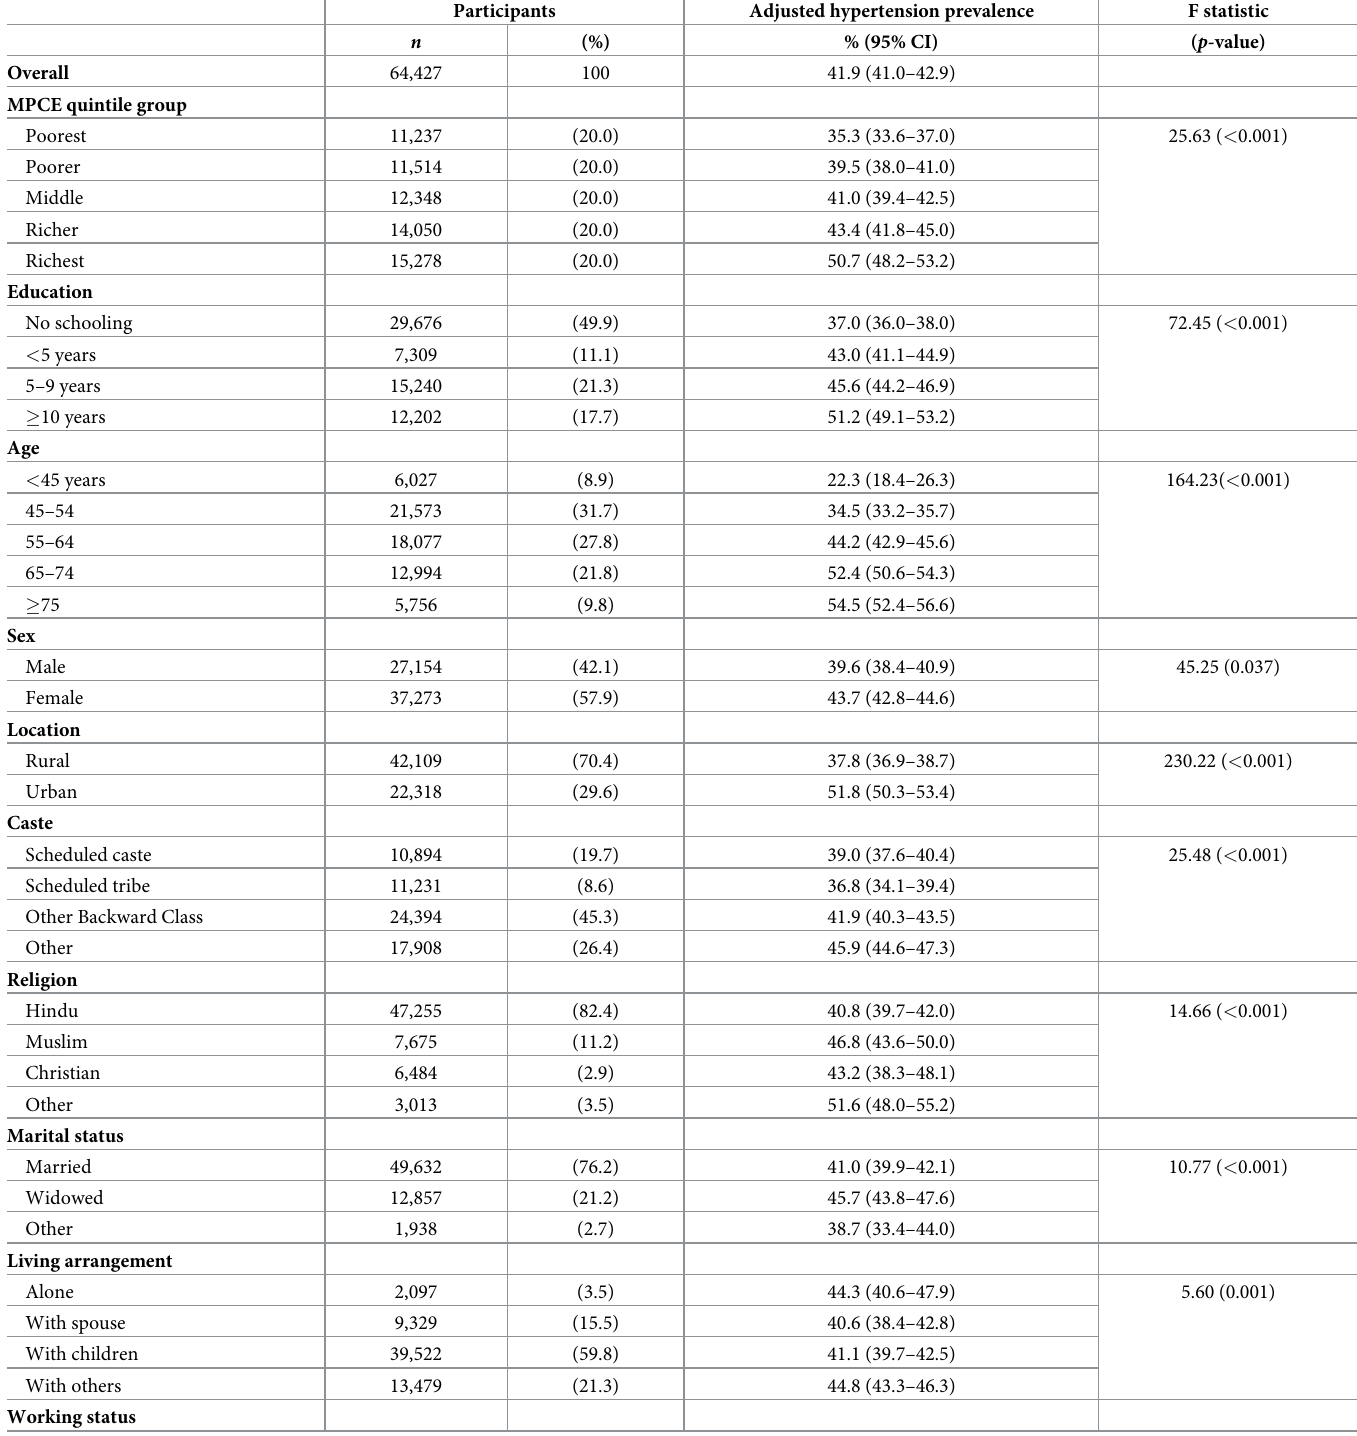
Table 1. Participant characteristics and adjusted hypertension prevalence, adults aged 45 years and over and their